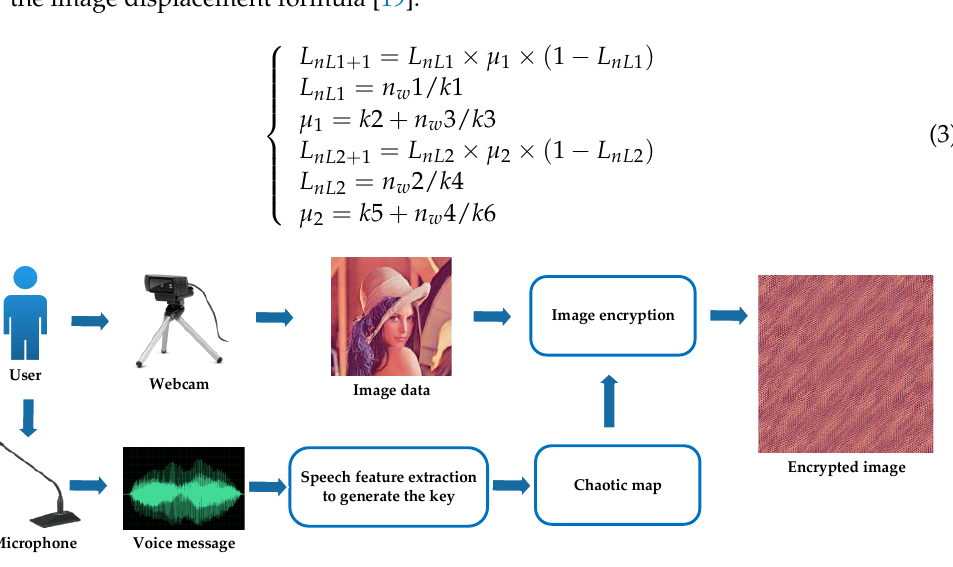
Figure 1. Speech feature extraction. ( a ) Original voice. ( b ) Step1: Single-syllable audio; ( c ) Step2: Single waveform of single-syllable audio; ( d ) Step3: Repetitive synthetic audio of a single waveform; ( e ) Step4: DFT conversion of a single waveform repeatedly synthesized for three seconds of audio.